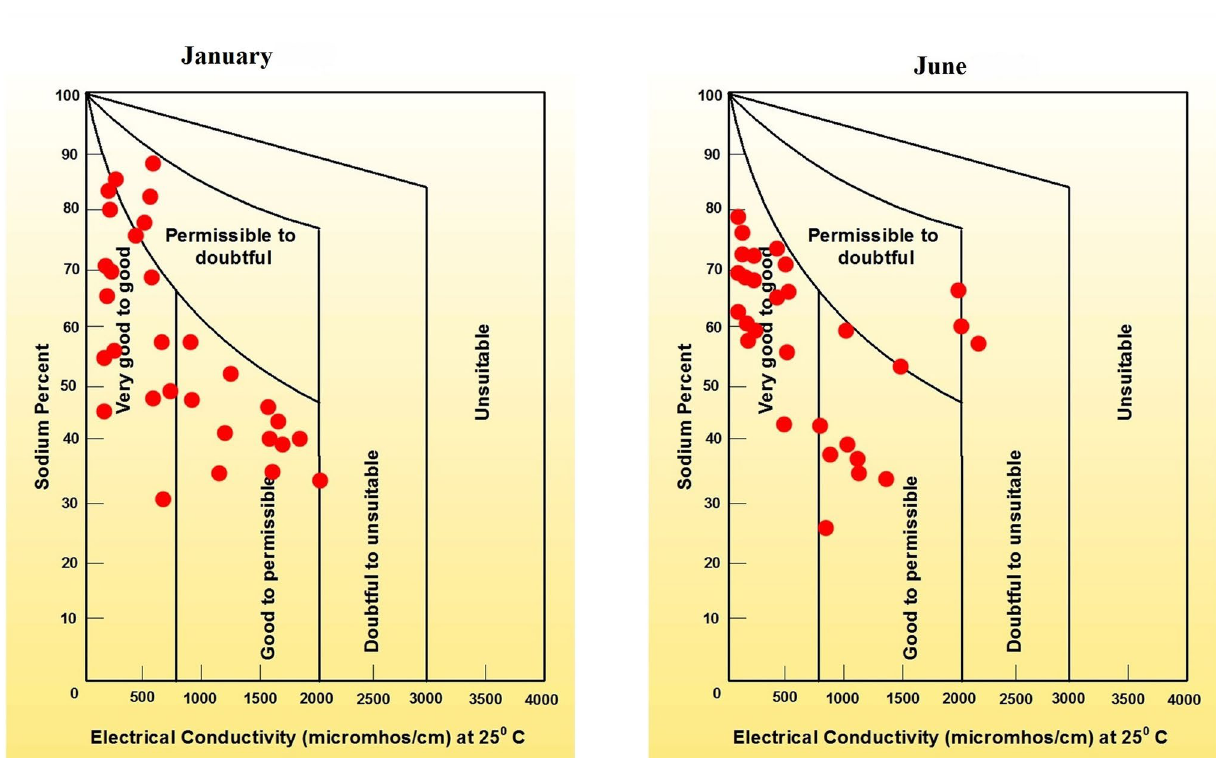
Fig. 8 Classification of irrigation water quality with respect to total salt concentration and